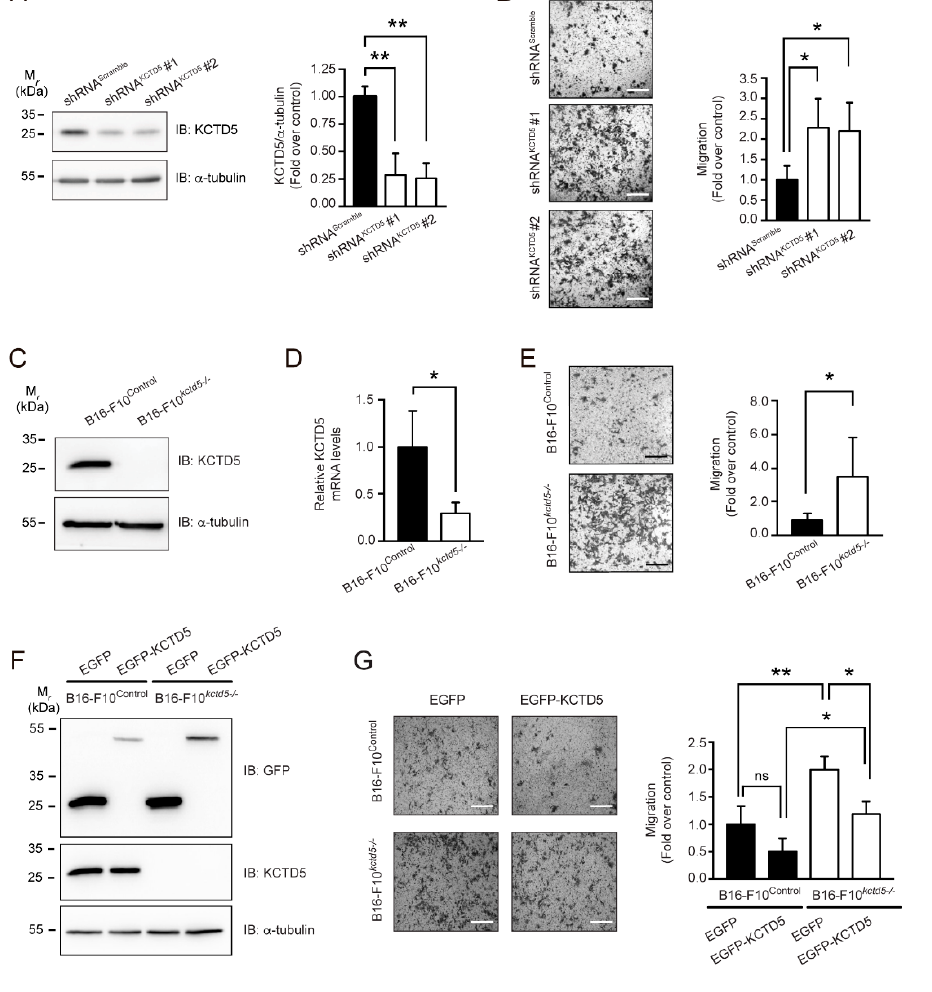
Figure 1. Potassium Channel Tetramerization Domain 5 (KCTD5) regulates migration of B16-F10 cells. ( A ) Evaluation of KCTD5 levels by immunoblot in B16-F10 cells transfected with shRNA Scramble , shRNA KCTD5 # 1 or shRNA KCTD5 #2 encoding plasmids. The KCTD5 levels were normalized to α -tubulin